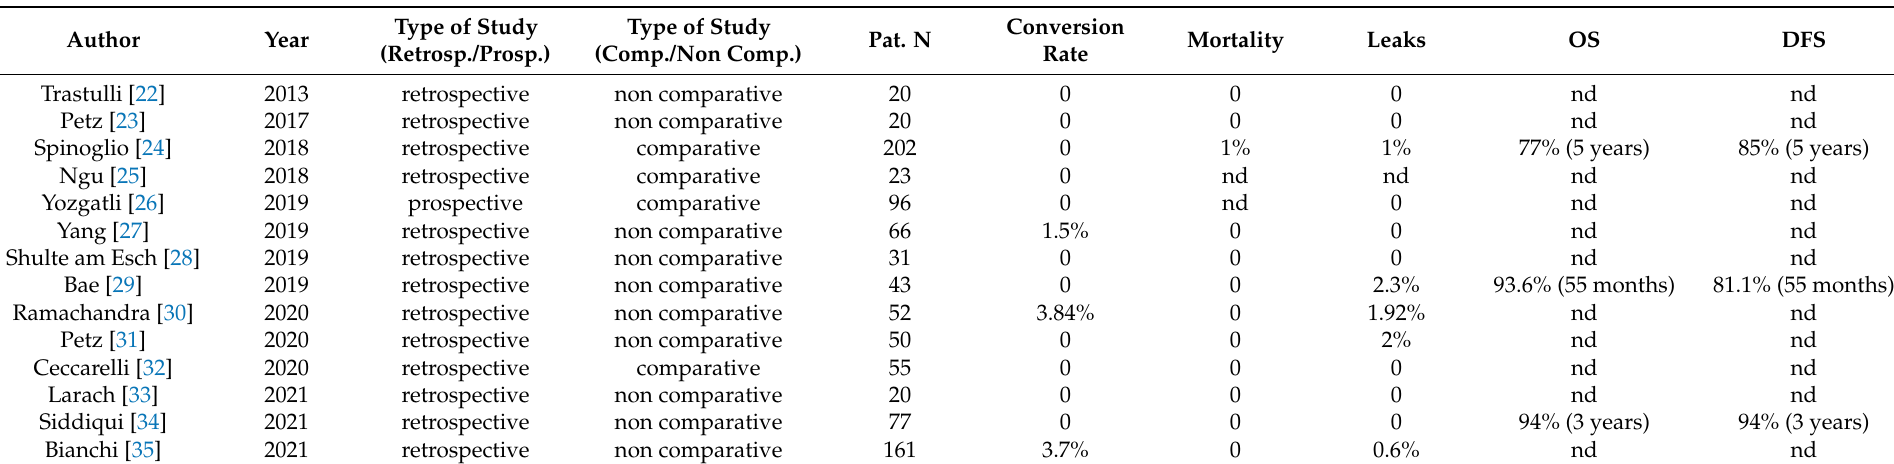
Table 1. Characteristics and principal results of the included